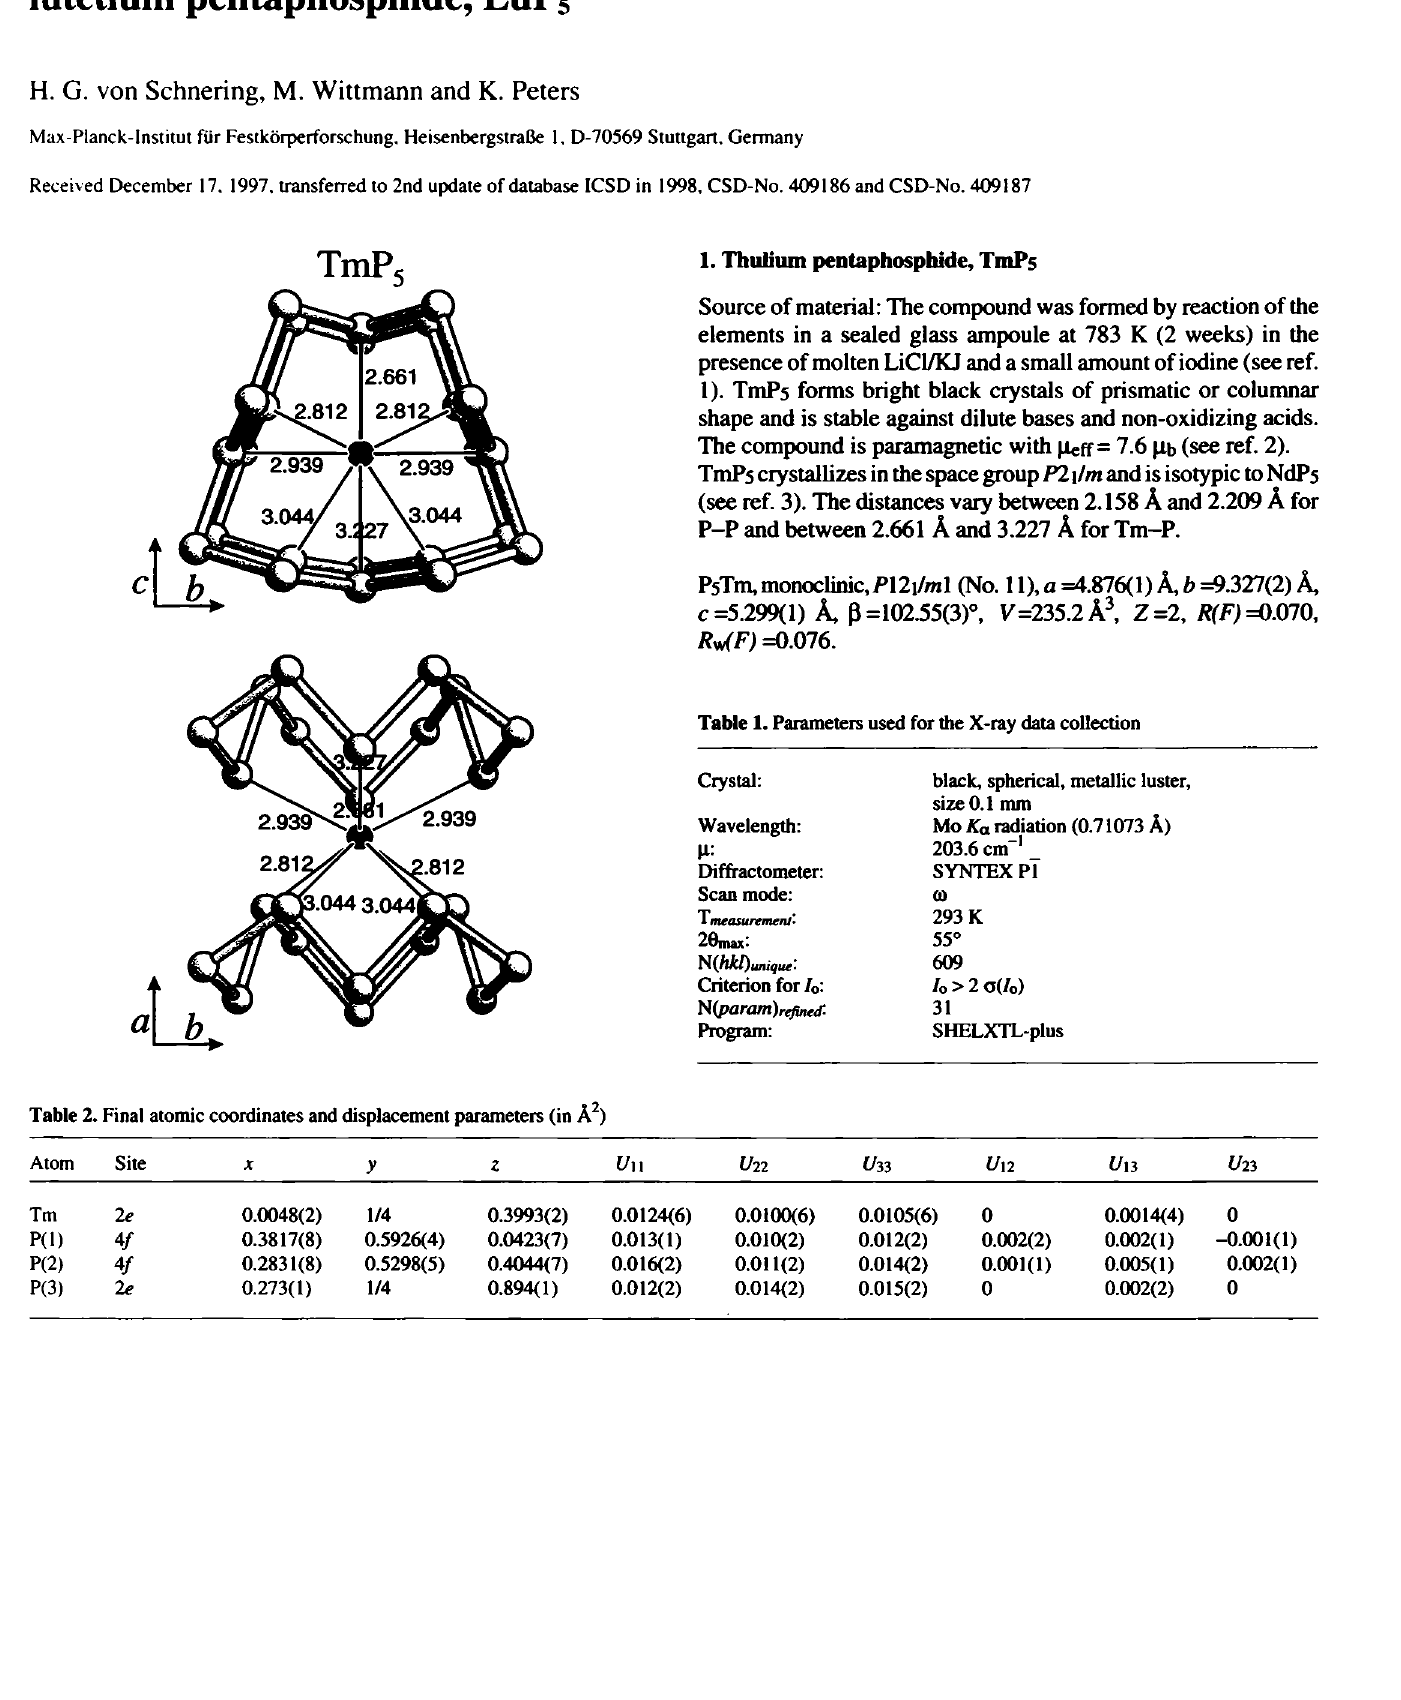
Table 2. Final atomic coordinates and displacement parameters (in Â^)